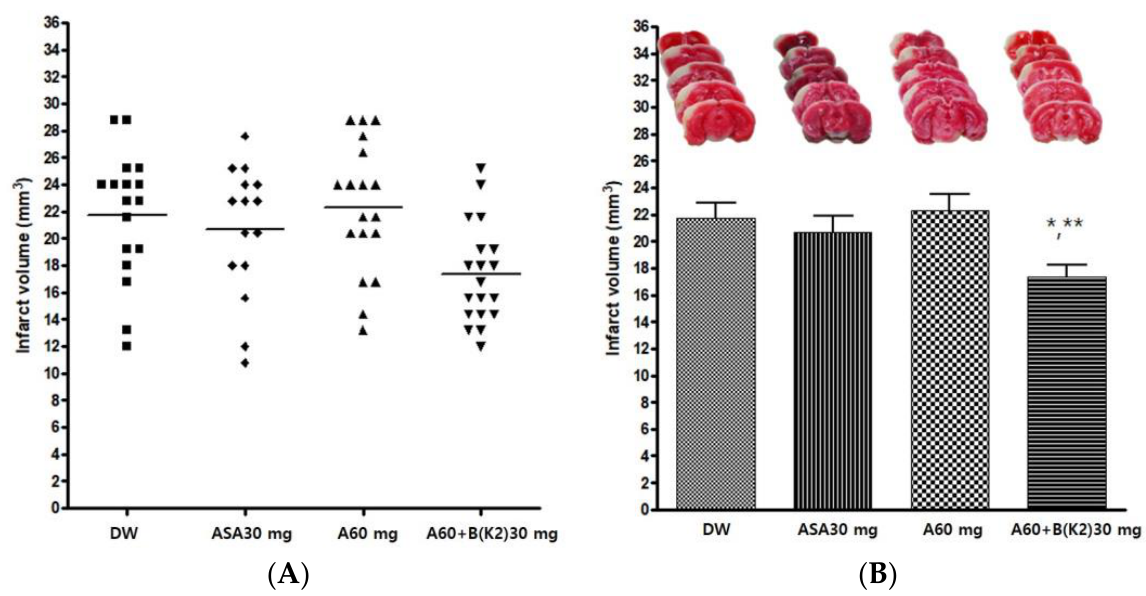
Figure 5. Effects of experimental drug A60+B(K2) 30 mg/kg on ischemic brain injury after permanent